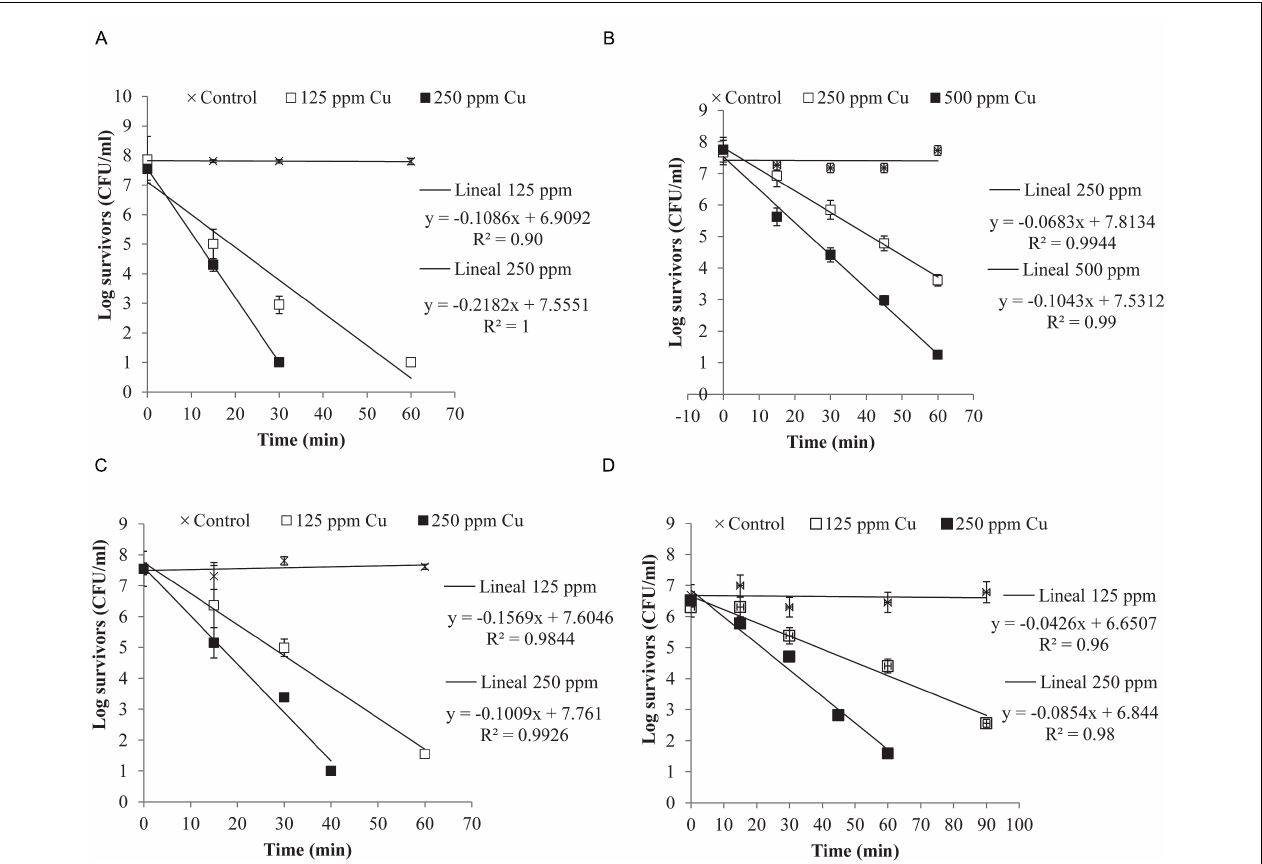
FIGURE 4 | Inactivation curves of copper of four isolates from clinical mastitis: (A) Escherichia coli (Al-563), (B) CNS (MT-163), (C) S. aureus (MT-359), and (D) S. uberis (MT-360). The isolates were exposed to different concentrations of copper. Bacterial counts were analyzed by CFU assay. Each determination was made in triplicate.